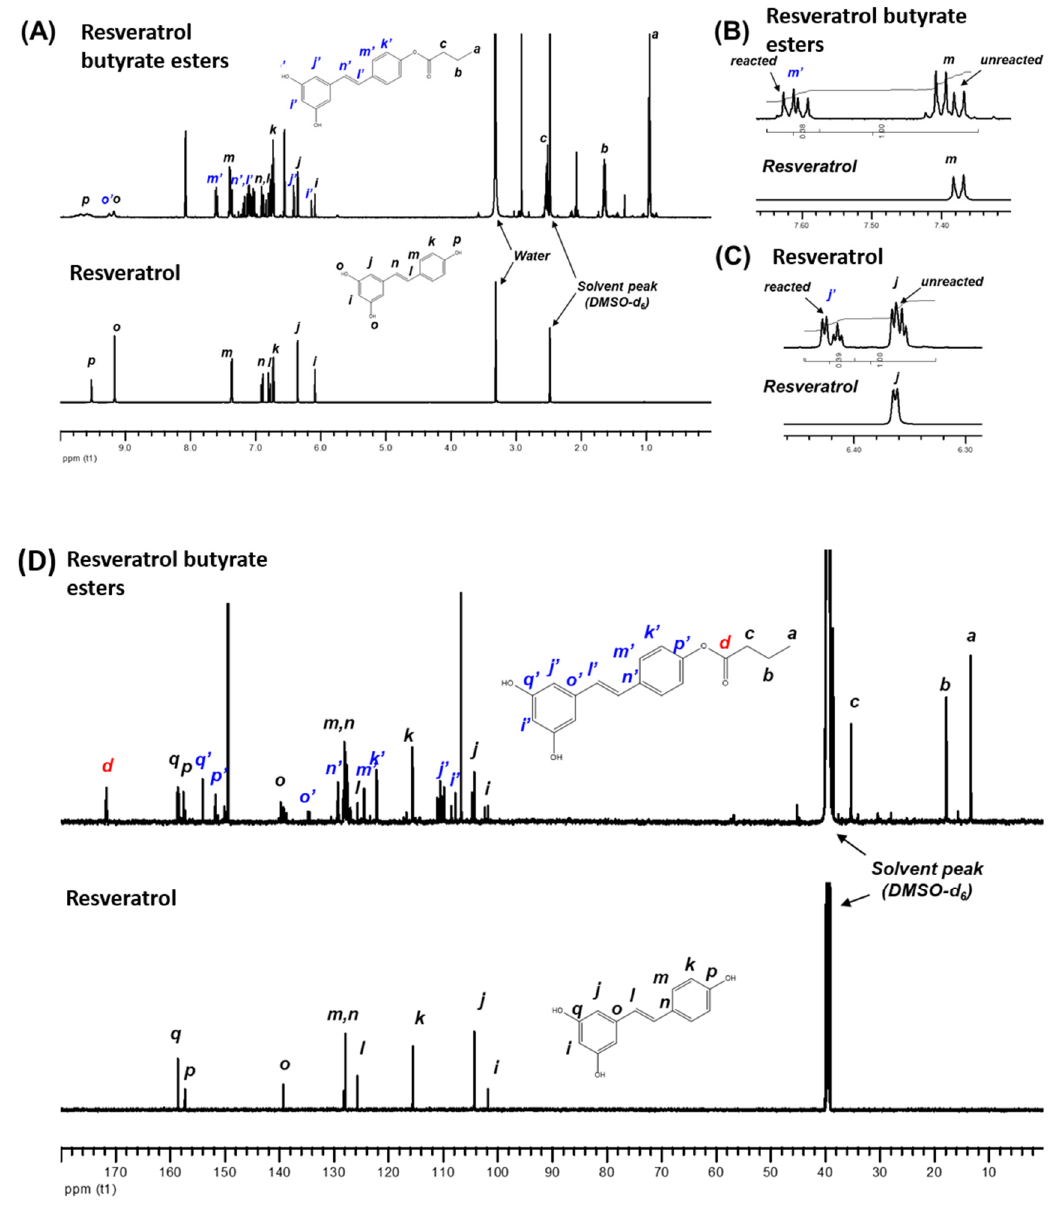
Figure 4. NMR spectra of resveratrol and RBE ( A ) 1 H NMR spectra of resveratrol and RBE. ( B ) 1 H NMR spectra of resveratrol and RBE reacted and unreacted segmentation from 7.32 to 7.66 ppm (t1). ( C ) 1 H NMR spectra of resveratrol and RBE reacted and unreacted segmentation from 6.46 to 6.30 ppm (t1). ( D ) 13 C NMR spectra of resveratrol and RBE.